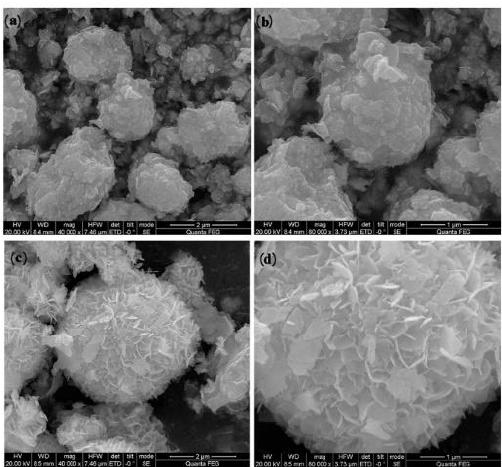
Figure 9. SEM images of Bi 2 O 3 ( a , b ); 1:1-Bi/BiOBr ( c , d ). Adapted with permission from Yuan XY et al.